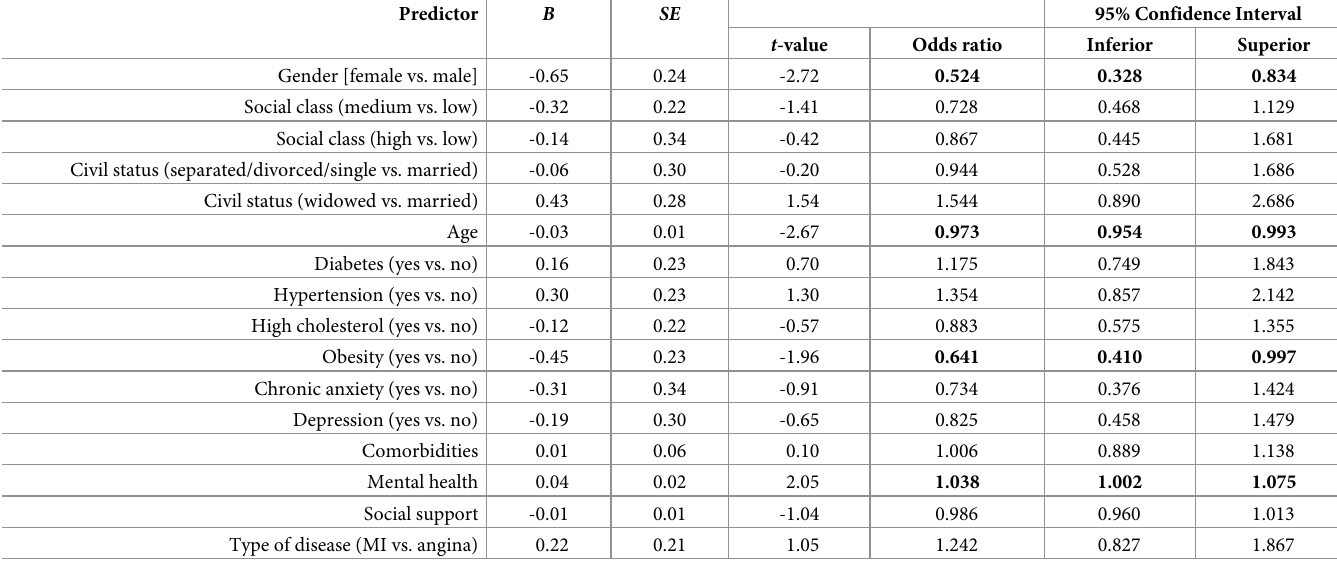
Table 3. Results from multiple ordinal logistic